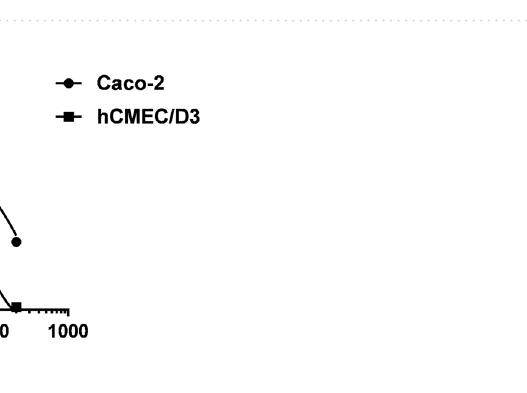
Figure 8. Dose-dependent cytotoxicity of compound 14 towards Caco-2 and hCMEC/D3